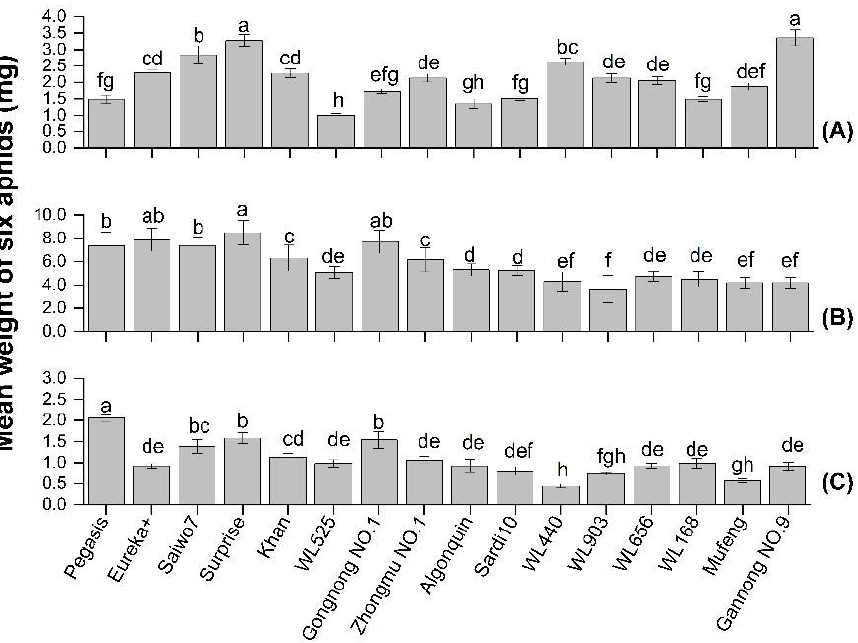
Figure 1. The weight of ( A ) cowpea aphid (CPA), ( B ) pea aphid (PA), ( C ) spotted aphid (SAA) on 16 alfalfa cultivars after culture for four days (Note: Different lower-case letters indicated significant differences among the cultivars ( p < 0.05).